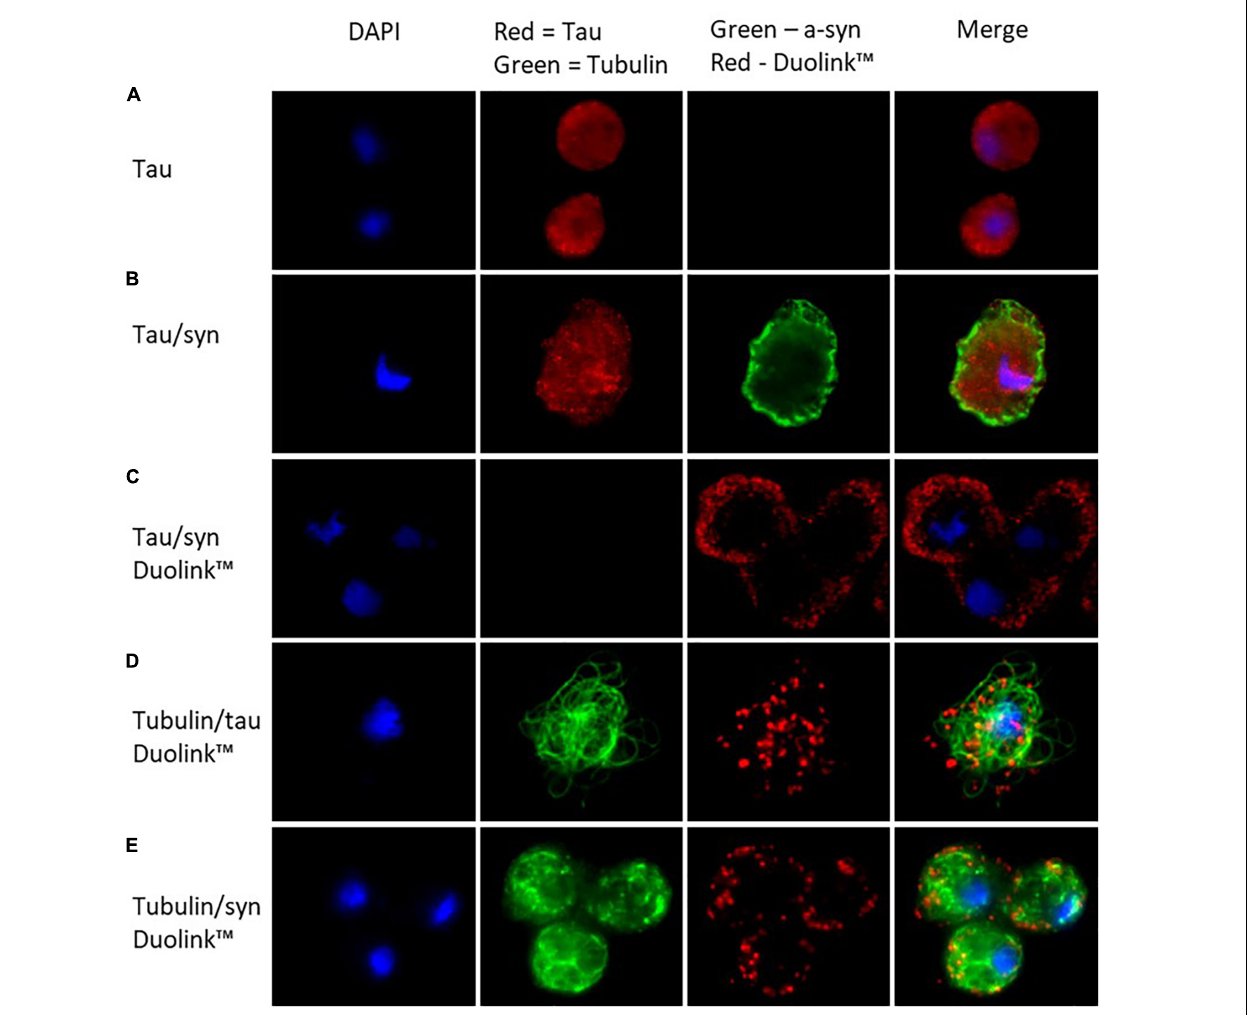
FIGURE 2 | In D. discoideum tau localises throughout the cytoplasm of the cell while α -synuclein concentrates at the cortex. The colocalisation of the two proteins takes place at the cortex of the cell where α -synuclein is most concentrated. (A) Tau was detected in the tau transformant using an anti-tau primary antibody and observed using Alexa-Fluor 594 conjugated secondary antibody. (B) α -synuclein was detected using an anti- α -synuclein antibody and visualised using Alexa Fluor 488 conjugated secondary antibody along with tau in the cotransformant. (C) To view colocalisation of tau and α -synuclein the cotransformants were stained with mouse anti-tau antibody and rabbit anti- α -synuclein antibody, the protein–protein interaction was observed (as red dots) using secondary proximity probes, anti-rabbit MINUS and anti-mouse PLUS in the Duolink textrmTM in situ detection kit (Sigma-Aldrich). To visualise colocalisation of tau or α -synuclein with tubulin Duolink textrmTM was again used, this time using a mouse-anti-tubulin primary antibody and rabbit-anti-tau or anti- α -synuclein antibodies. An additional Alexa-Fluor 488 conjugated secondary antibody was added in with the proximity probes in order to visualise tubulin. (D) Tau colocalised with tubulin throughout the cytoplasm of the cell. (E) The colocalisation of tubulin and α -synuclein occurred at the cortex of the cell where α -synuclein is most